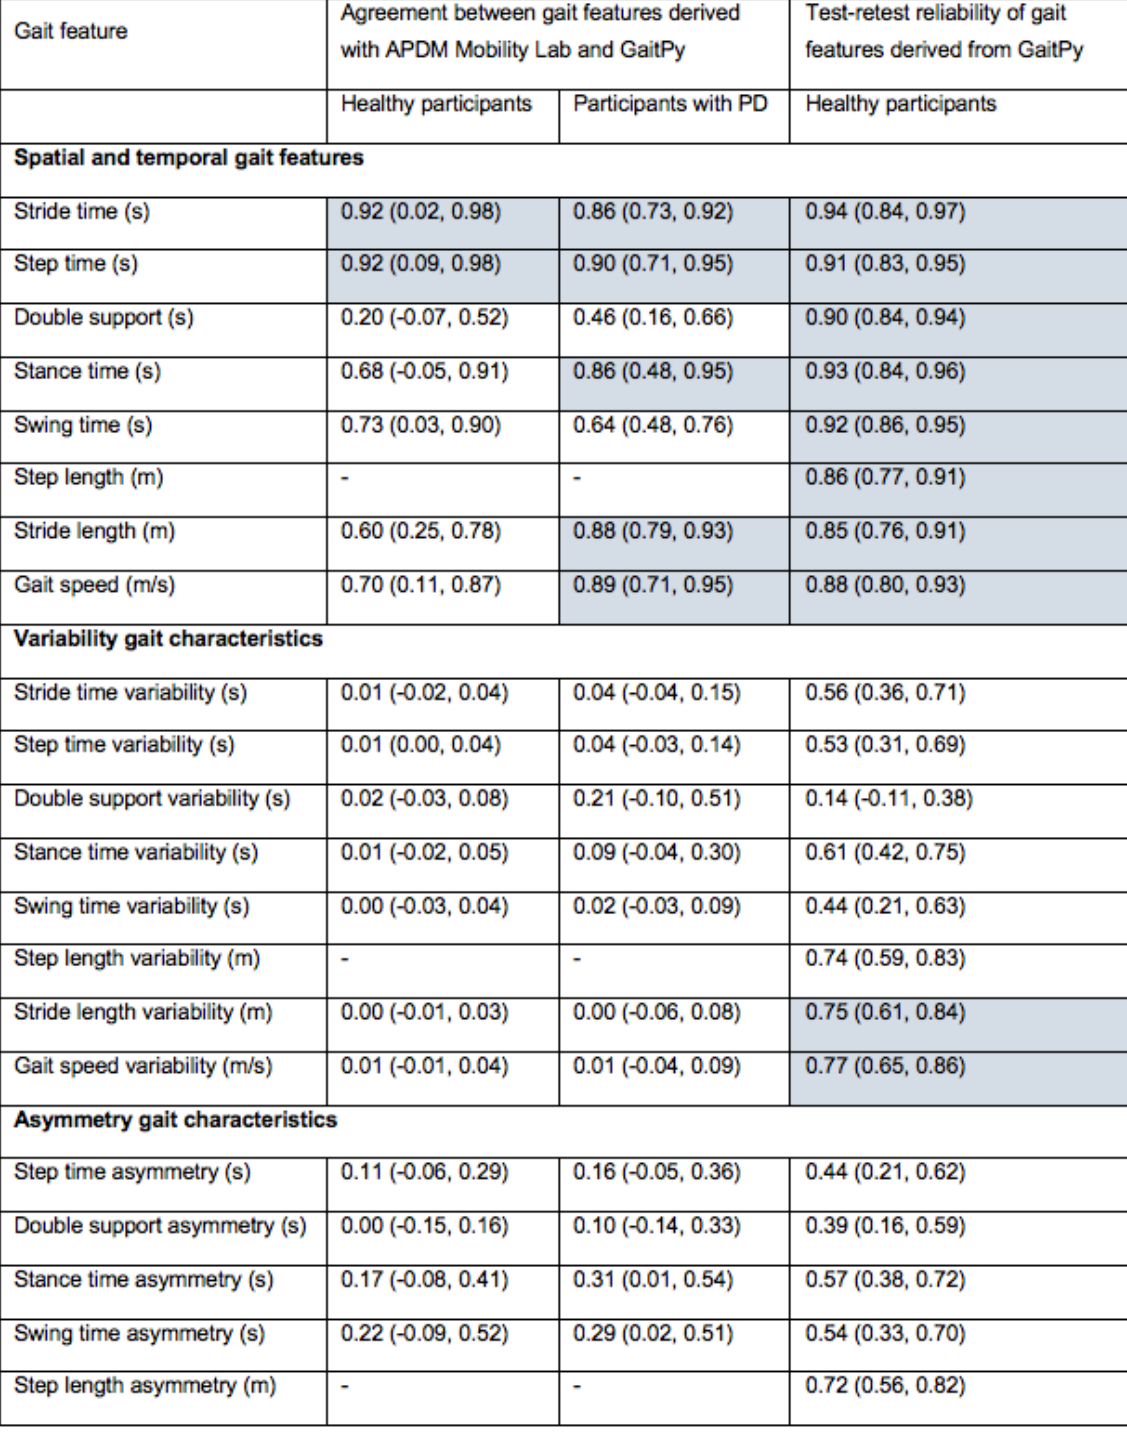
Figure 1. Agreement between gait features derived using the APDM Mobility Lab and GaitPy and test-retest reliability of gait features derived with GaitPy in healthy participants. Intraclass correlation coefficient values showing excellent agreement (between 0.75 and 1) are highlighted in blue. PD: Parkinson